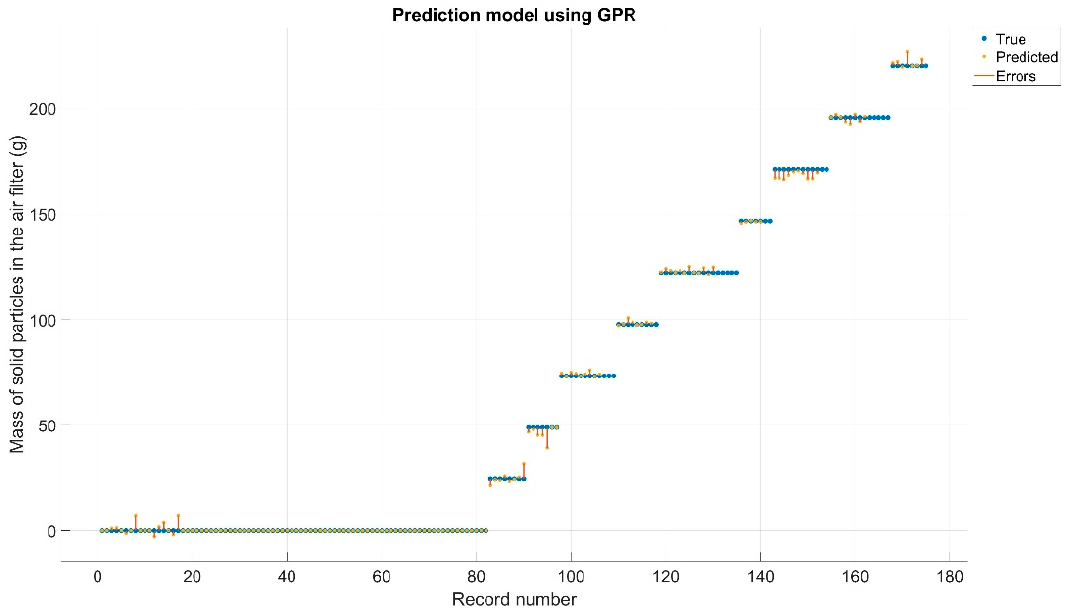
Figure 9. Response of the Gaussian process regression model after validation process.